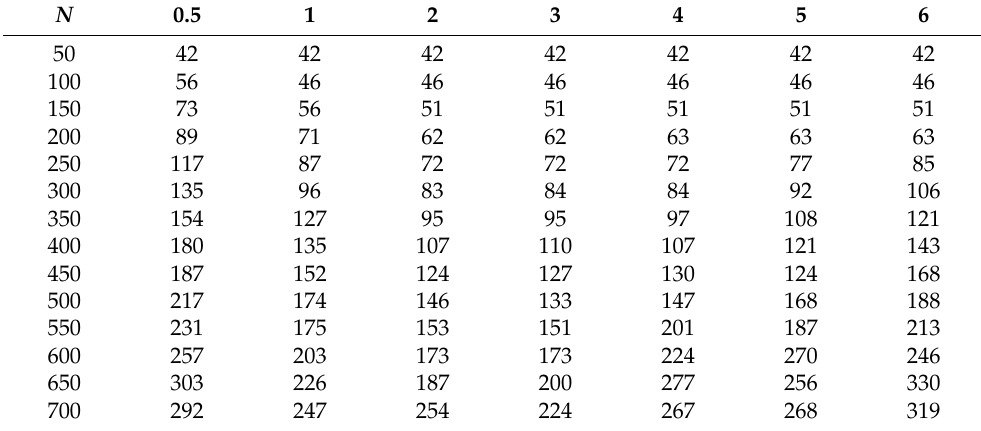
Table 7. The relationship between the number of evacuees and RSET when D max is different. N